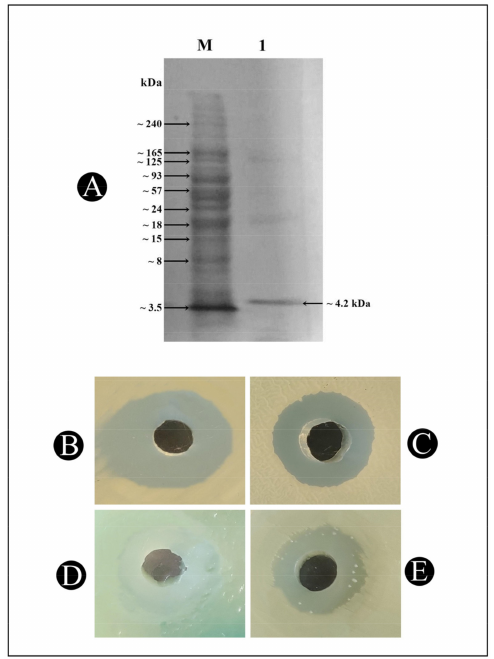
Figure 3. ( A ) Determination of molecular weight of bacteriocin by SD-SPAGE. Lane M contains